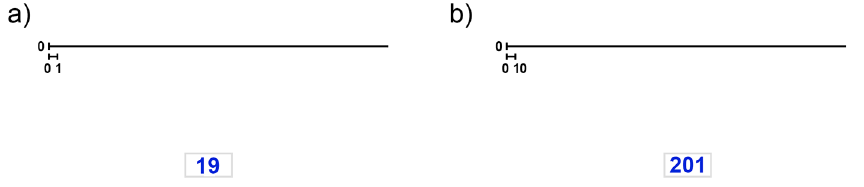
Figure 3. Examples of the 0-40 unbounded NLT (a) and the 0-400 unbounded NLT (b). Bounded